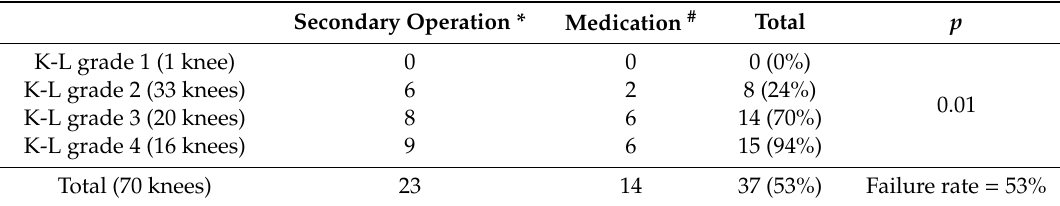
Table 4. Treatment failure rate of the BMAC injection (5-year follow-up). Secondary Operation * Medication